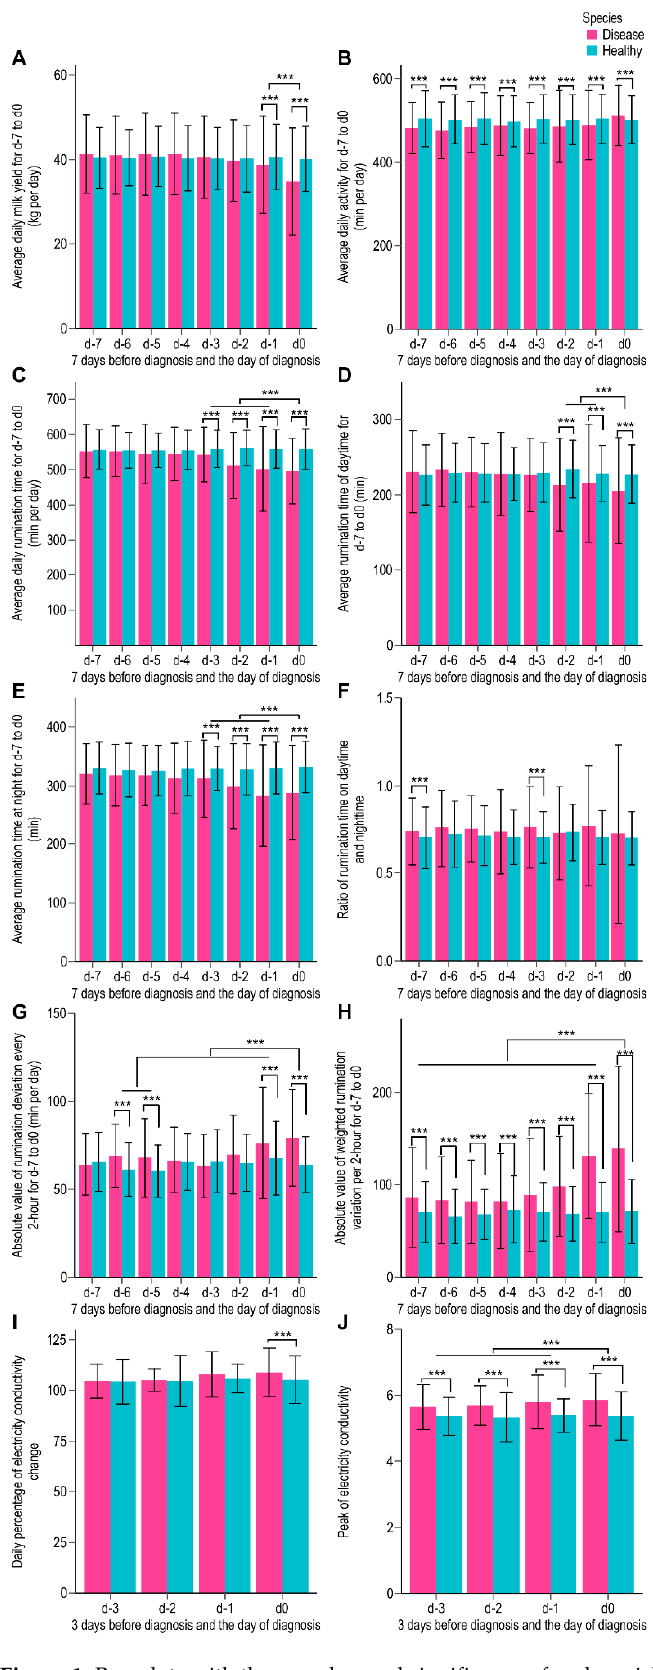
Figure 1. Box plots with the error bar and significance of each variable for cows with health disorders and healthy ones. Subgraphs ( A ) depicts the difference of daily milk yield of the cows with